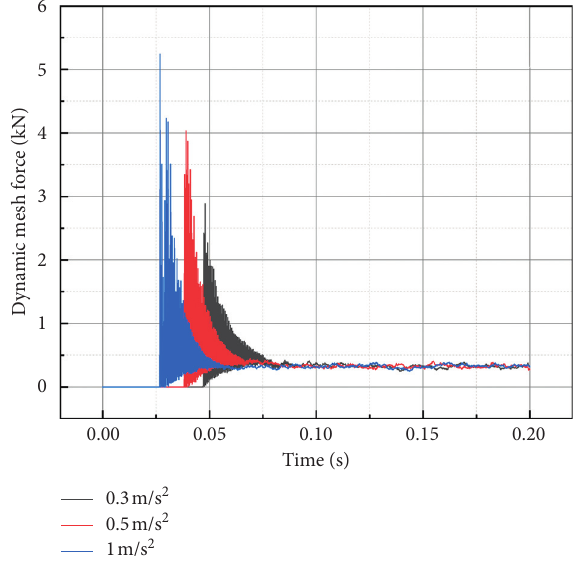
Figure 9: The comparison of meshing force of spline coupling under three loading cases.